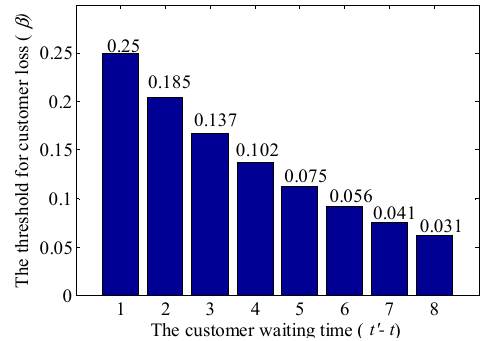
Figure 11. The rate of customer loss threshold.